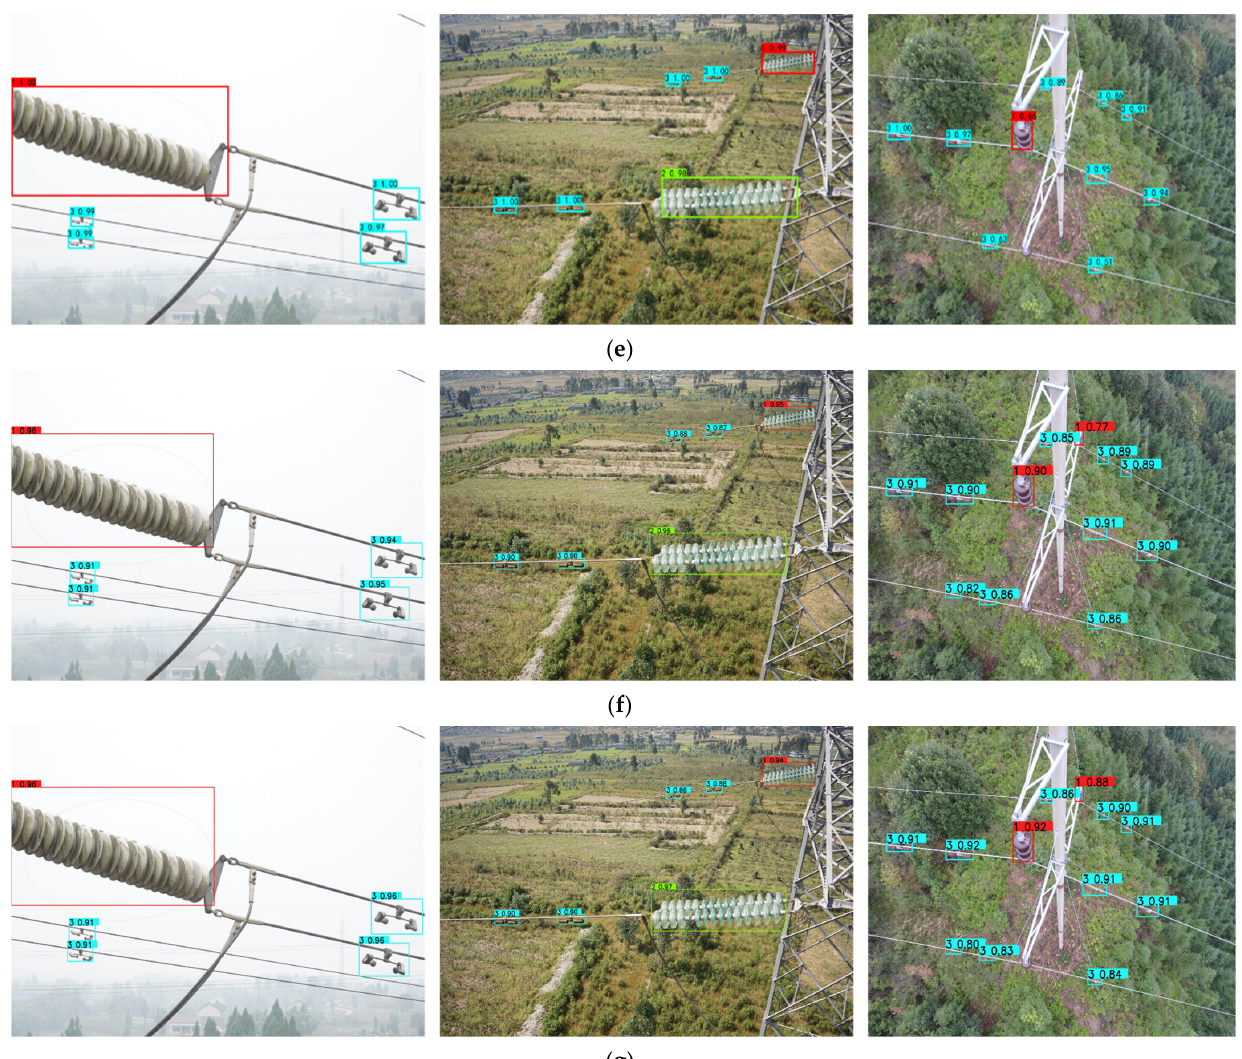
Figure 15. Results on the test dataset: ( a ) original images; ( b ) SSD; ( c ) RetinaNet; ( d ) CenterNet; ( e ) YOLOv4; ( f ) YOLOv5x; ( g ) proposed method. Table 7. Detection results for some mainstream object detection networks.